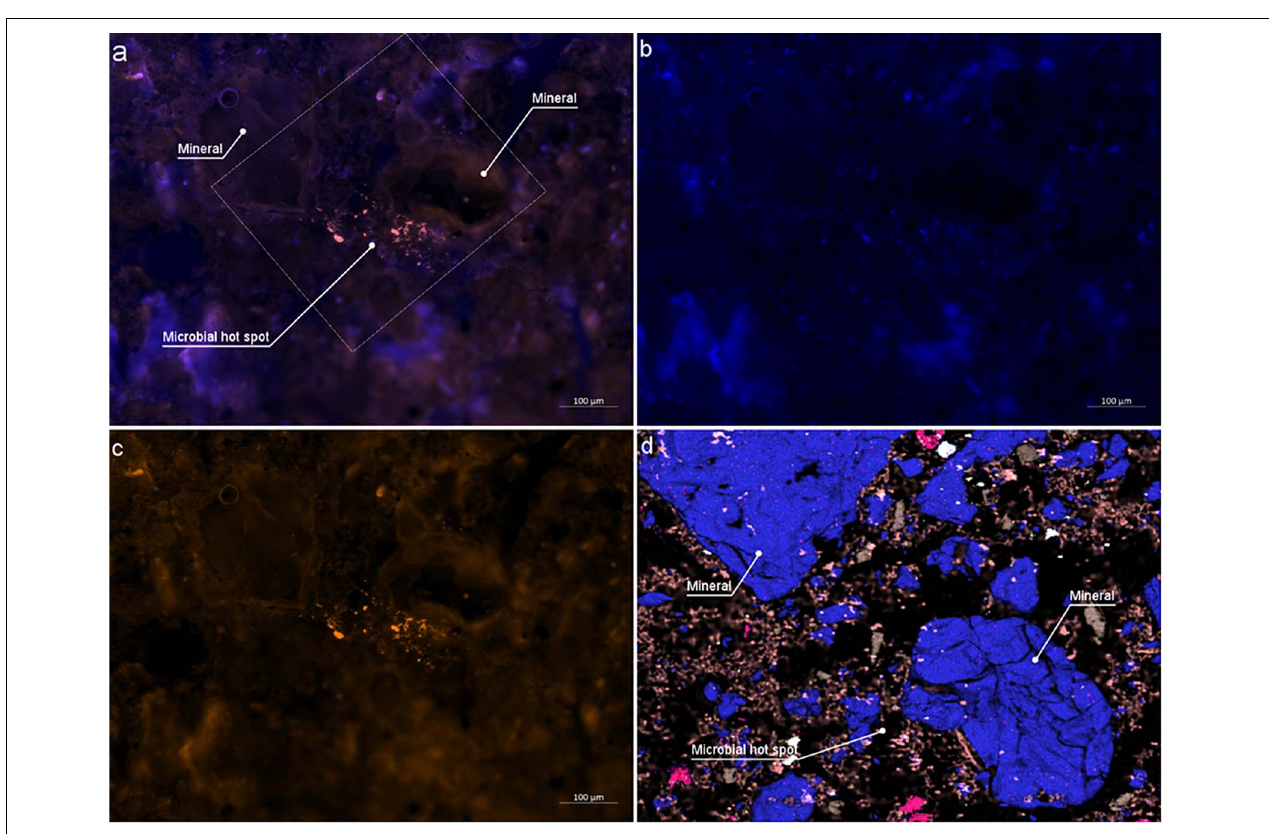
FIGURE 8 | Catalyzed Reporter Deposition-Fluorescence in situ Hybridization (CARD-FISH) stained bacteria colonizing on Rhizosphere mineral. (a) Epifluorescence micrograph of combined DAPI and DsRed channel. Outlined square shows the area investigated by EDX analysis (b) DAPI channel (c) DsRed channel (d) Same area imaged by EDX. Two larger minerals indicate Si rich minerals where bacterial aggregates are